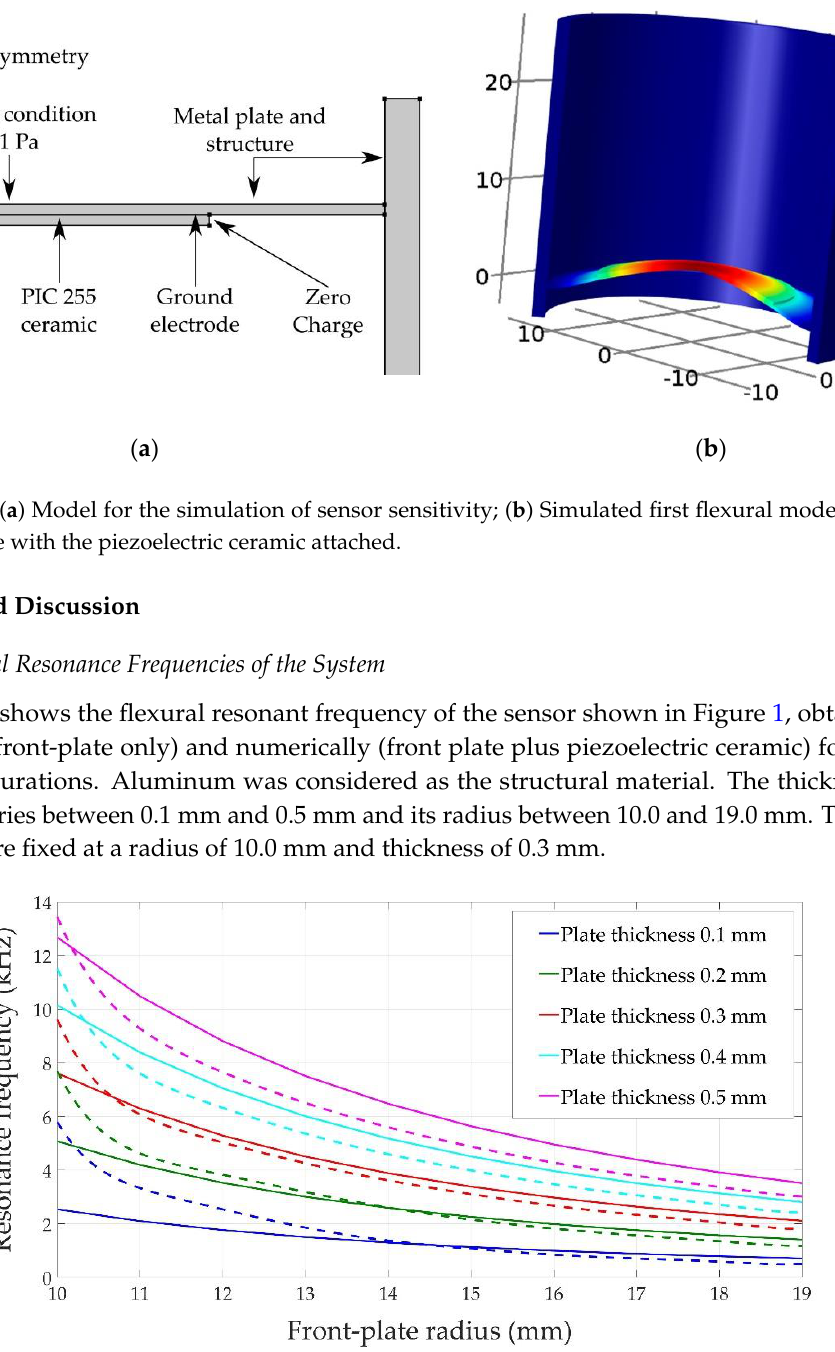
Figure 5. Flexural first mode resonance frequency of a circular aluminum plate obtained analytically (solid lines) and numerically with a piezoelectric ceramic attached (dashed lines).